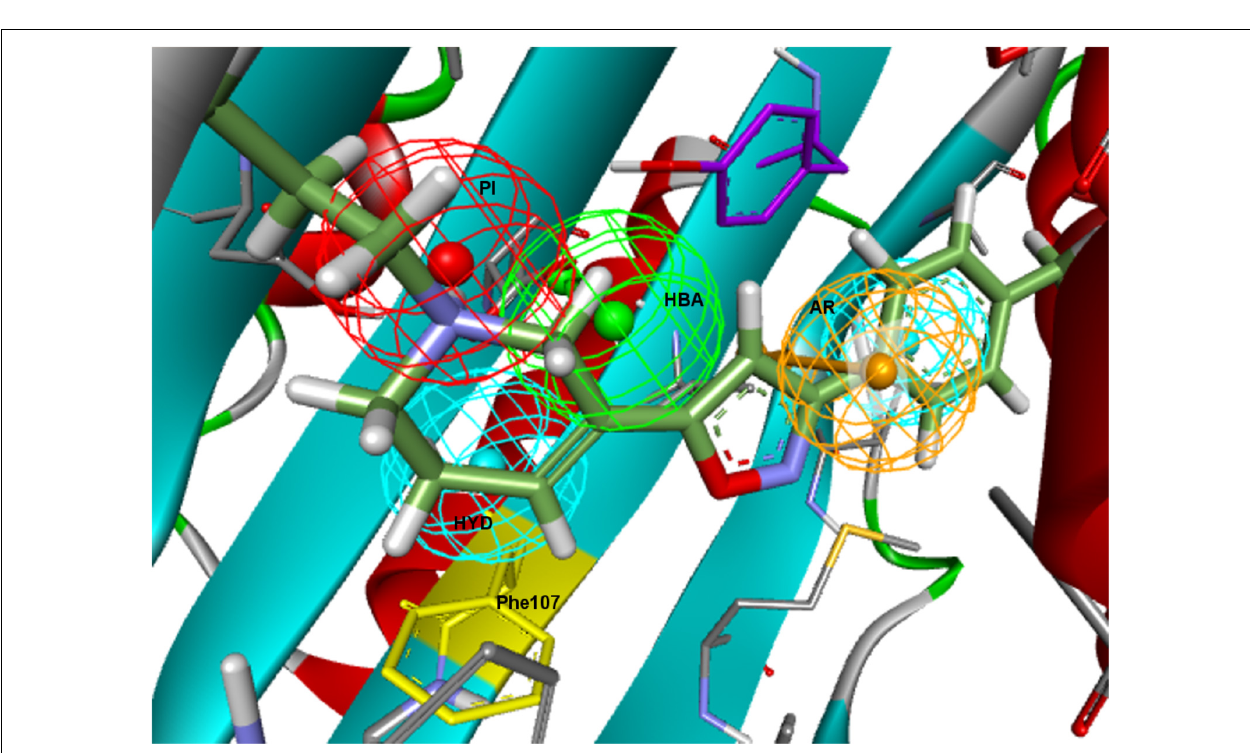
FIGURE 6 | Banister–Ph positioned in the binding site by rigid ligand-fit and displacement. The HYD under the PI might stand for interactions with other HYD aminoacids, mainly with Phe107 (in